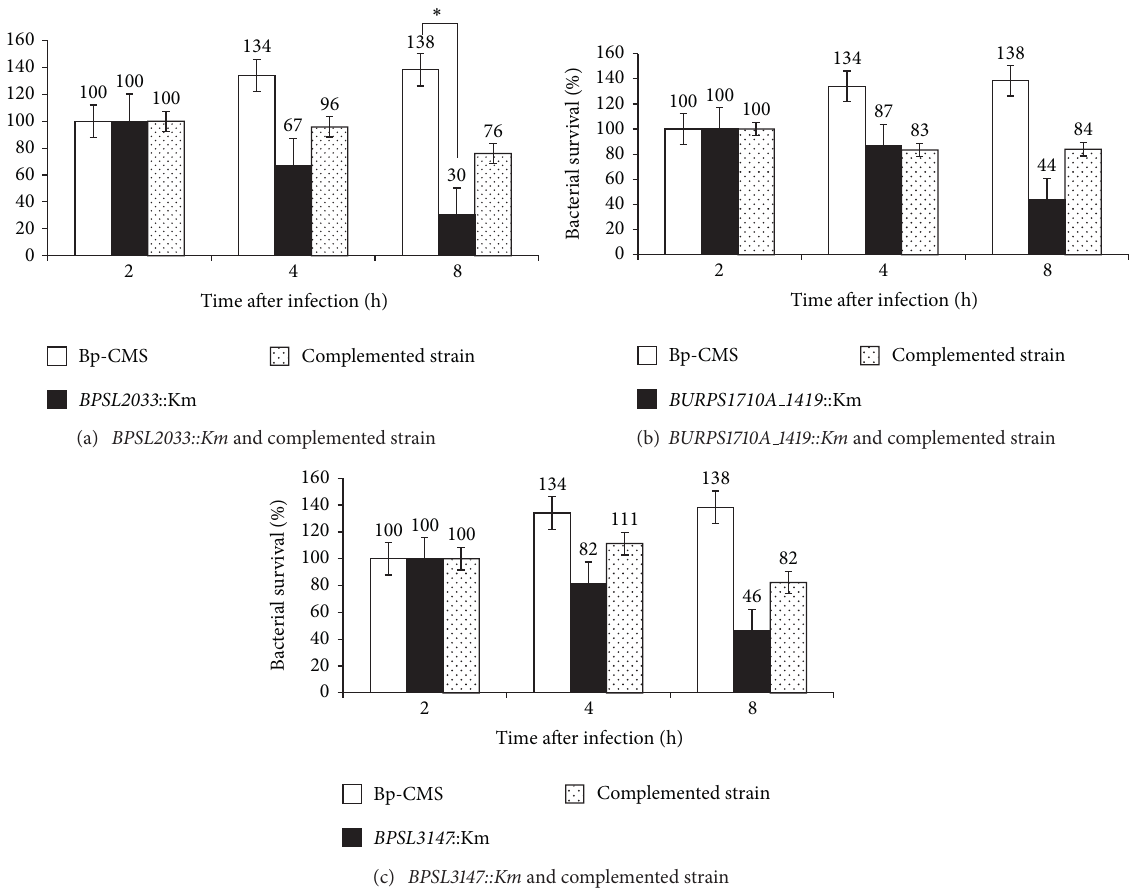
Figure 2: Bacterial survival and replication within RAW264.7 macrophage-like cells infected at MOI of 100 using wild-type strain and the insertion mutants as well as their complemented strains. Data represents means and standard errors of 3 separate experiments; each experiment was carried out in 3 technical replicates for each time point. Asterisk indicates significant differences ( P < 0.05) relative to the wild-type strain Bp-CMS at each time point.